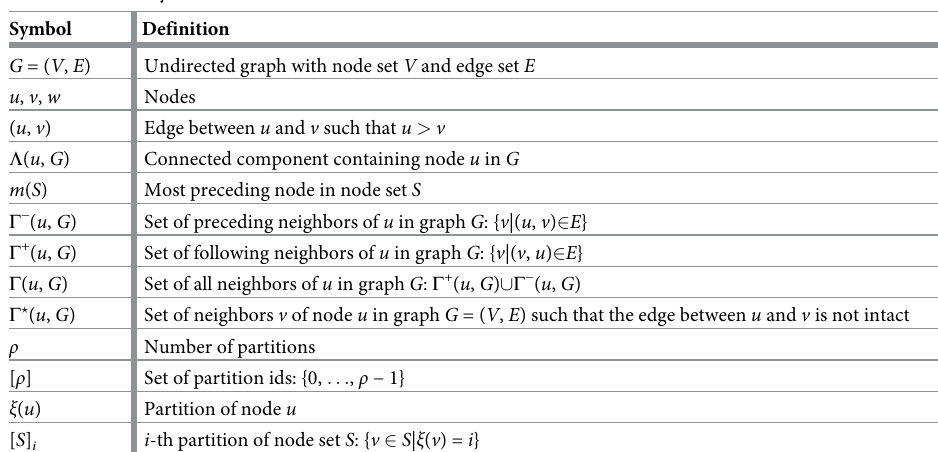
Table 1. Table of